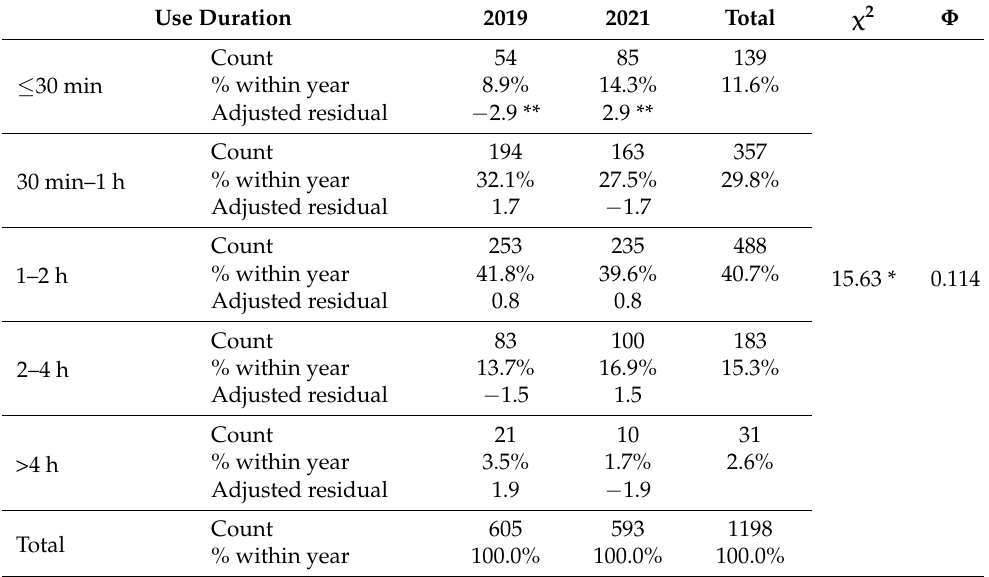
Table 3. Chi-square analysis of length of visits (2019 vs.